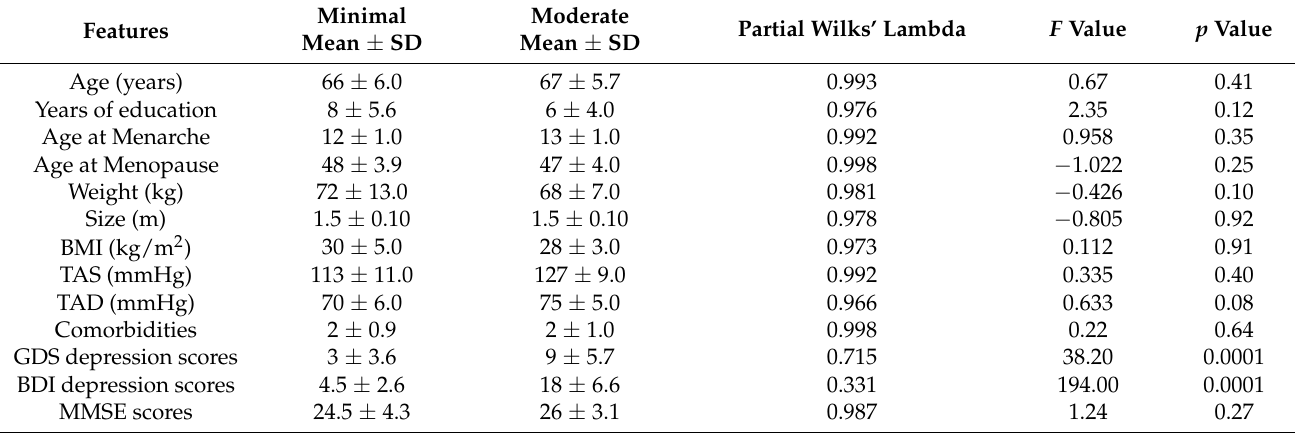
Table 1. Features of the elderly women with minimal and moderate depressive